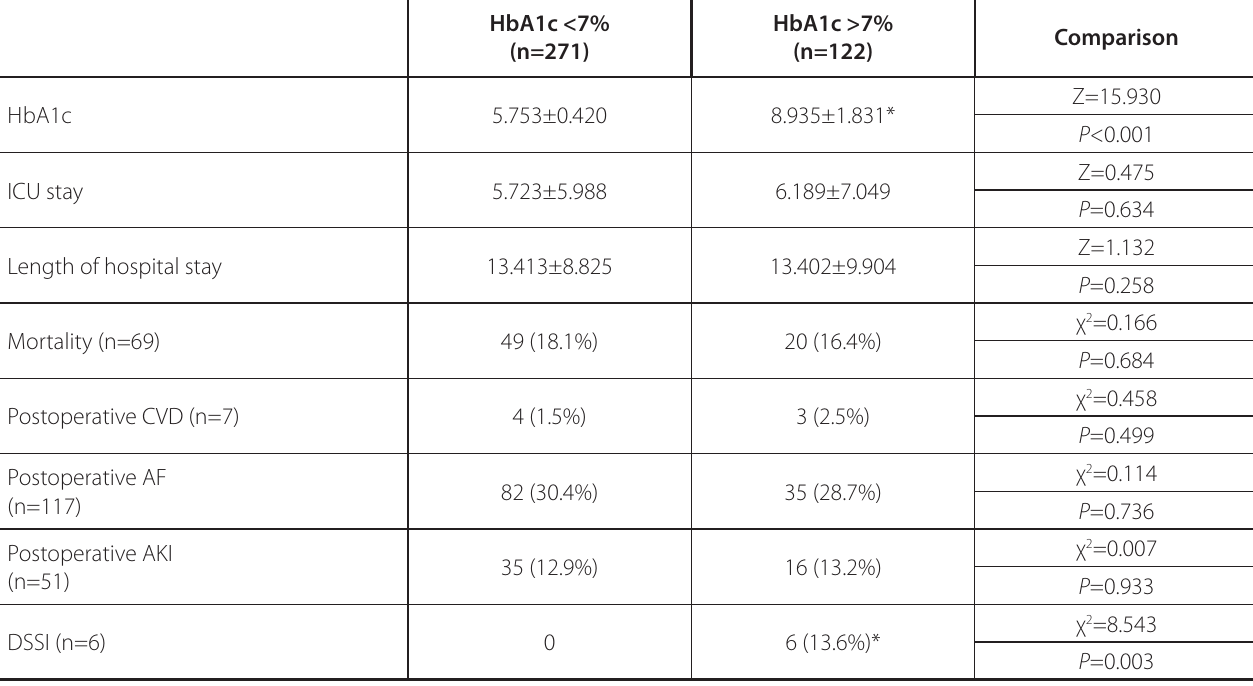
Table 3 . Evaluation of patients according to HbA1c